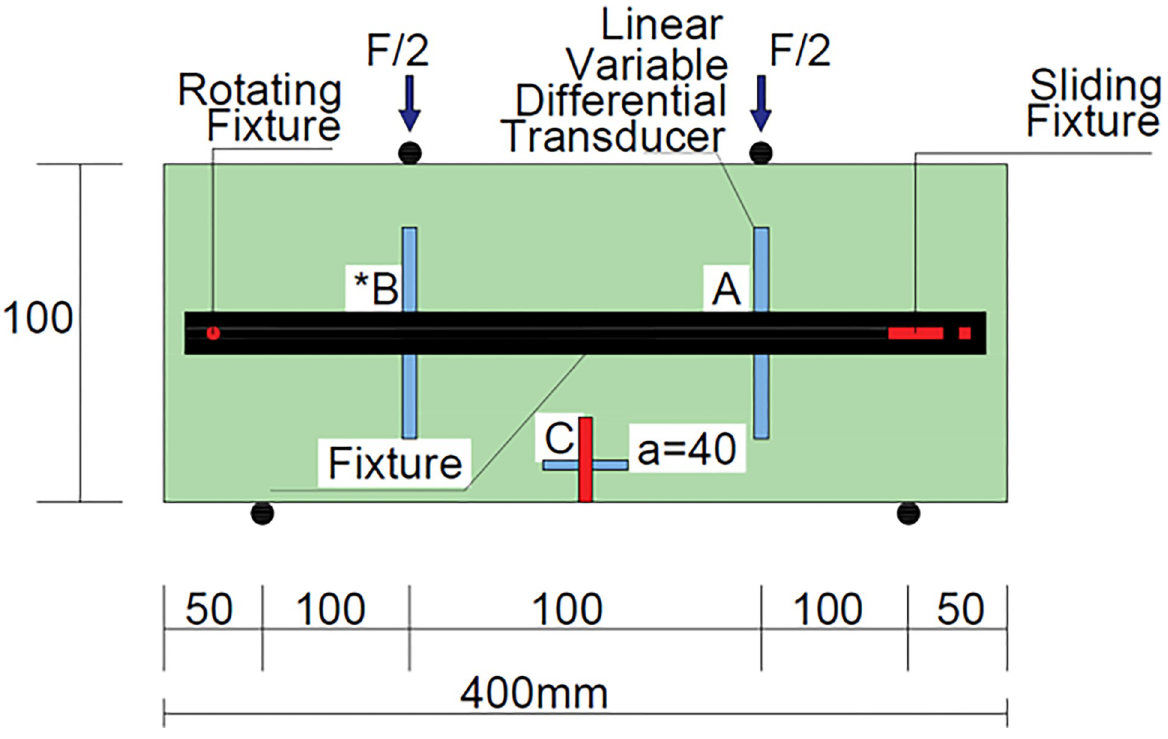
Fig 7. Test setup for fracture energy